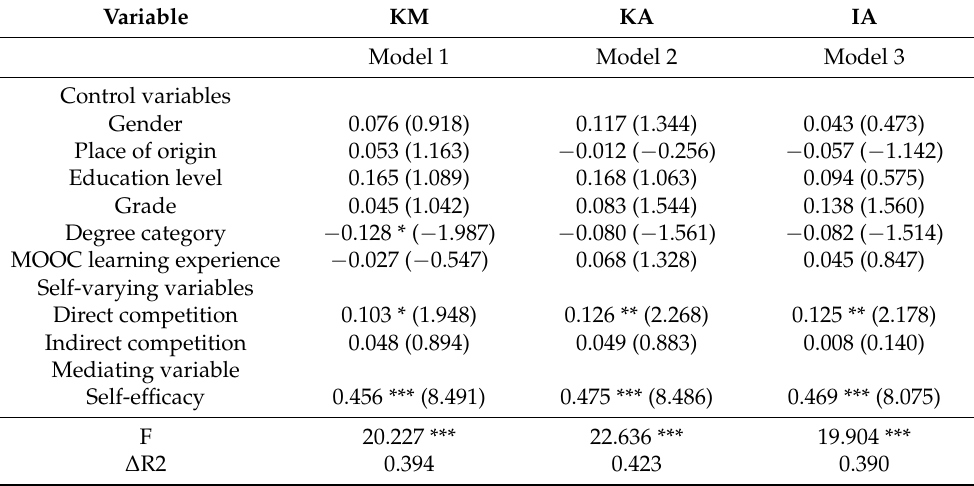
Table 2. Mediation effect test of